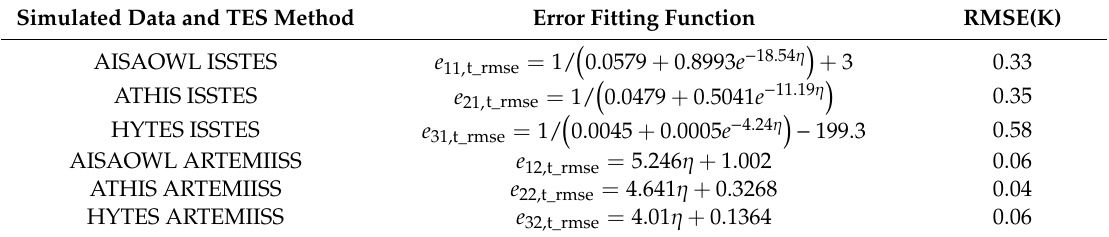
Figure 12. The graph of LST or LSE errors varying with NEDT when center wavelength shift ratio is in [ − 0.05, 0, 0.05] and FWHM change ratio is 0. The X axis is NEDT, and the Y axis is the LST error in ( a , c , e )and is the LSE error in ( b , d , f ). ( a , b ) Center wavelength shift ratio is 0. ( c , d ) Center wavelength shift ratio is 0.05. ( e , f ) Center wavelength shift ratio is − 0.05. Table 9. The LST error fitting function about NEDT when center wavelength shift ratio = 0 and FWHM change ratio = 0.